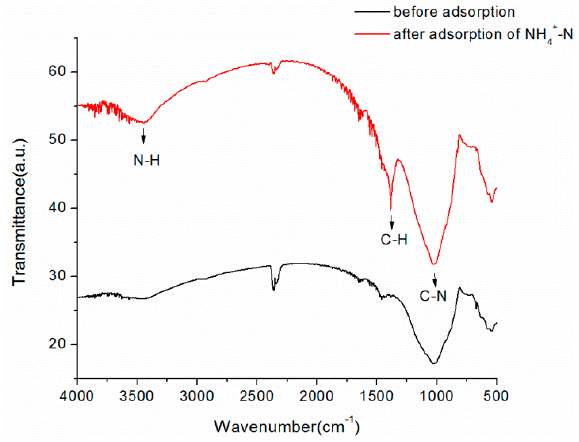
Figure 6. Fourier transform infrared (FT-IR) spectrum of scoria before and after NH 4+ -N removal.